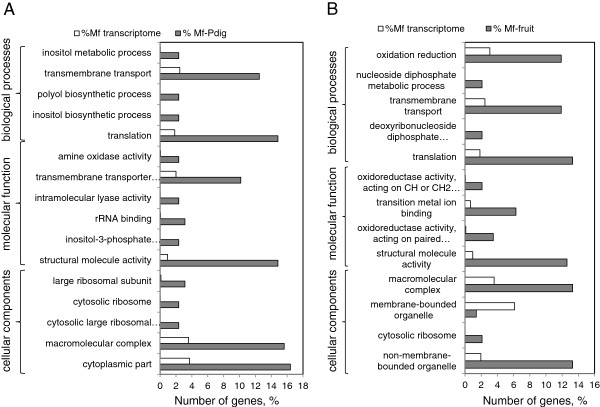
Gene ontology (GO) classification of the Metschnikowia fructicola differentially expressed genes. Summary of GO categories for the all transcribed genes in M. fructicola cells (Mf transcriptome) and differentially expressed genes in M. fructicola cells during interaction with P.digitatum (Mf-Pdig) (A) and during interaction with fruit (Mf-fruit) (B).